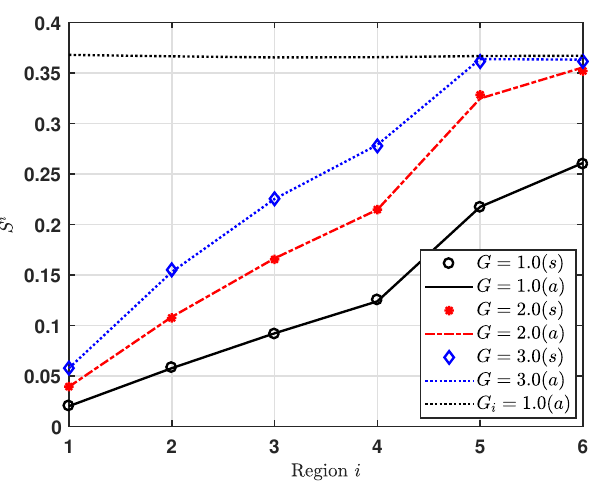
Figure 6. Normalized throughput vs. Region.